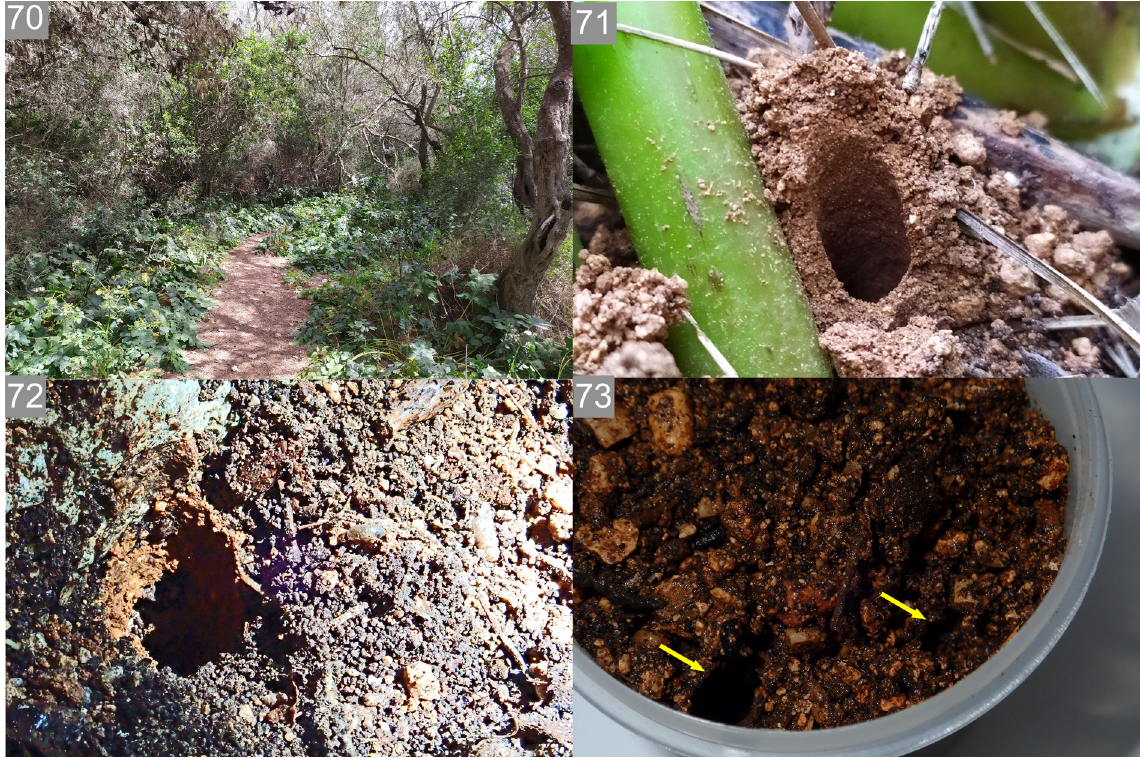
Figs 70–73. Nemesia maltensis sp. nov. observations. 70 . Natural habitat. 71 . Borrow top cut open, note virtual absence of a silk lining of the burrow shaft and the compacted soil from which the burrow walls derive most of their structural integrity. 72 . Natural burrow entrance flush with the soil surface, note absence of trapdoor. 73 . Two surface openings of the bifurcated burrow seen in an observation